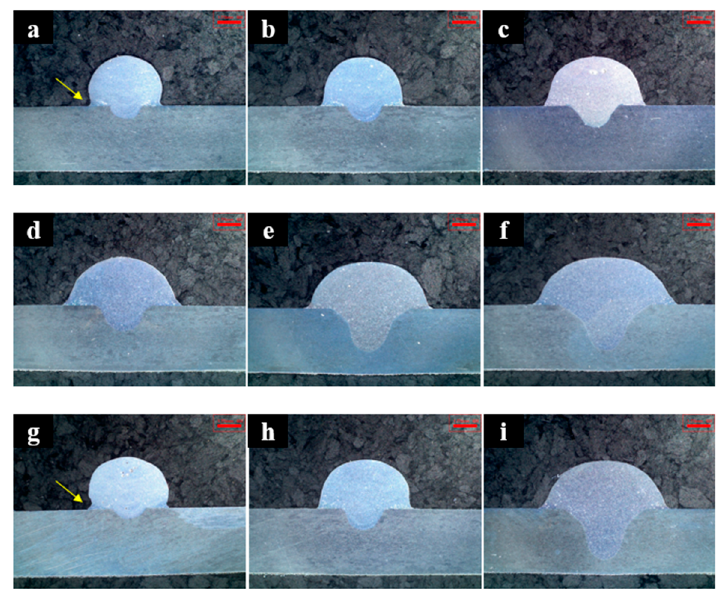
Figure 3. Macro-section images of a single bead according to MIG welding conditions of ( a ) 80 A, 17.1 V; ( b ) 87 A, 17.5 V; ( c ) 92 A, 18 V; ( d ) 102 A, 18.3 V; ( e ) 110 A, 18.4 V; ( f ) 118 A, 18.9 V; ( g ) 83 A, 16 V; ( h ) 95 A, 16.5 V; ( i ) 112 A, 17.2 V.